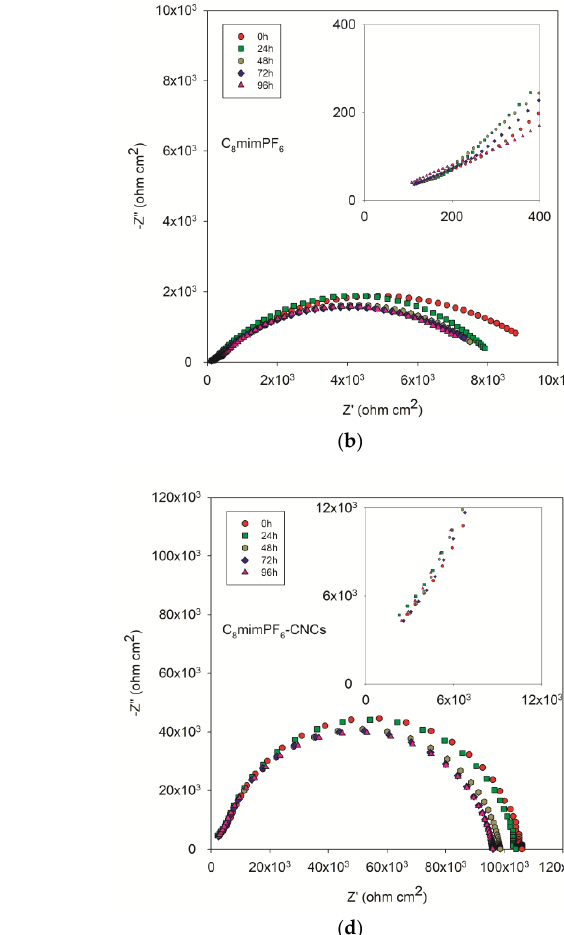
( d ) Figure 4. EIS parameters of coated samples in 3.5 wt% NaCl solution at different immersion periods. ( a ) Coating resistance, R C , ( b ) coating capacitance, C C , ( c ) charge transfer resistance, R ct , and ( d ) dou- ble-layer capacitance, CPE dl .